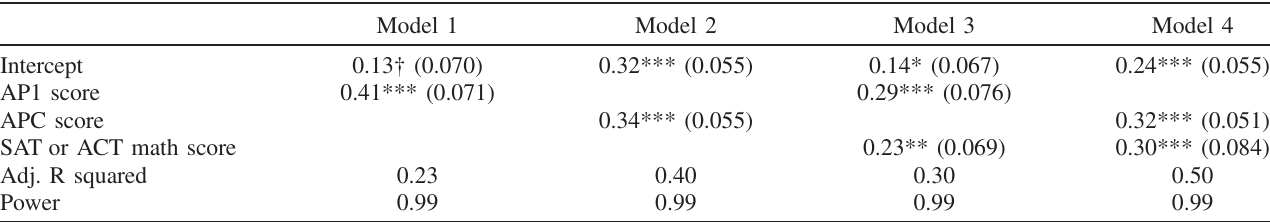
TABLE V. Regression model of physics 1 course grades on students ’ AP physics exam scores and SAT or ACT math scores. † p < 0 . 10 , * p < 0 . 05 , ** p < 0 . 01 , *** p < 0 . 001